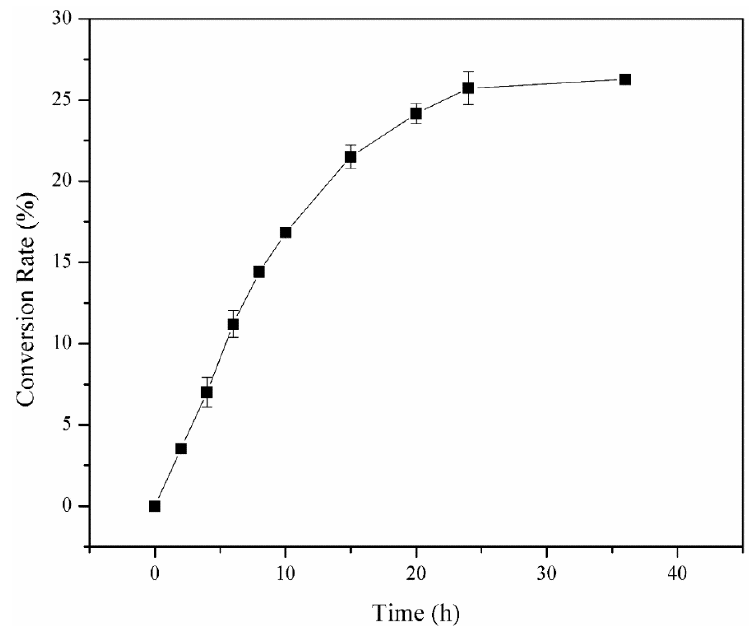
Figure 7. Time - course during the synthesis of isofloridoside with the α -galactosidase (data from HPLC analysis).